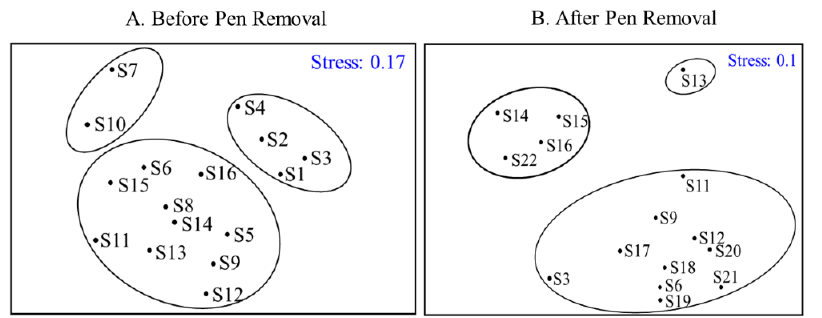
Figure 3. Results of clustering analysis of fish community sites from 2017 to 2018 ( A ) and from 2021 to 2022 ( B ) in Gehu Lake.